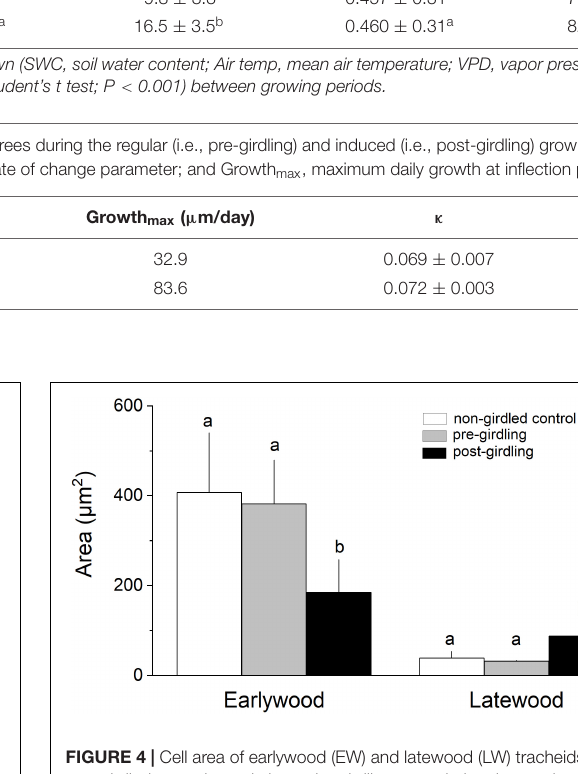
FIGURE 3 | Radial cell lumen diameter (CLD), cell wall thickness (CWT), and ratio of CLD:CWT of earlywood (EW) and latewood (LW) tracheids in non-girdled controls, and above the girdling zone during the regular (i.e., pre-girdling) and induced growing period (i.e., post-girdling). Student’s t test was applied to determine statistically significant differences of anatomical parameters between non-girdled controls, and pre- and post-girdling. Different letters indicate significant difference at P < 0.05.